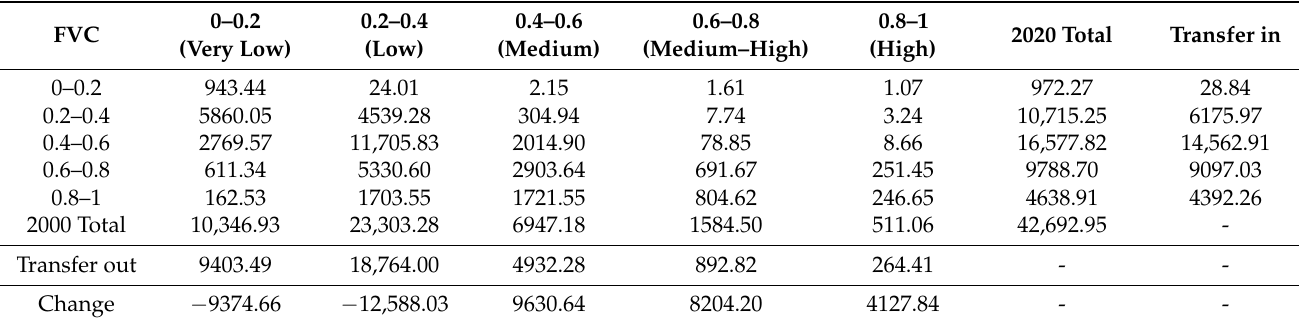
Table 1. Transfer matrix of FVC in 2000–2020 (unit: km 2